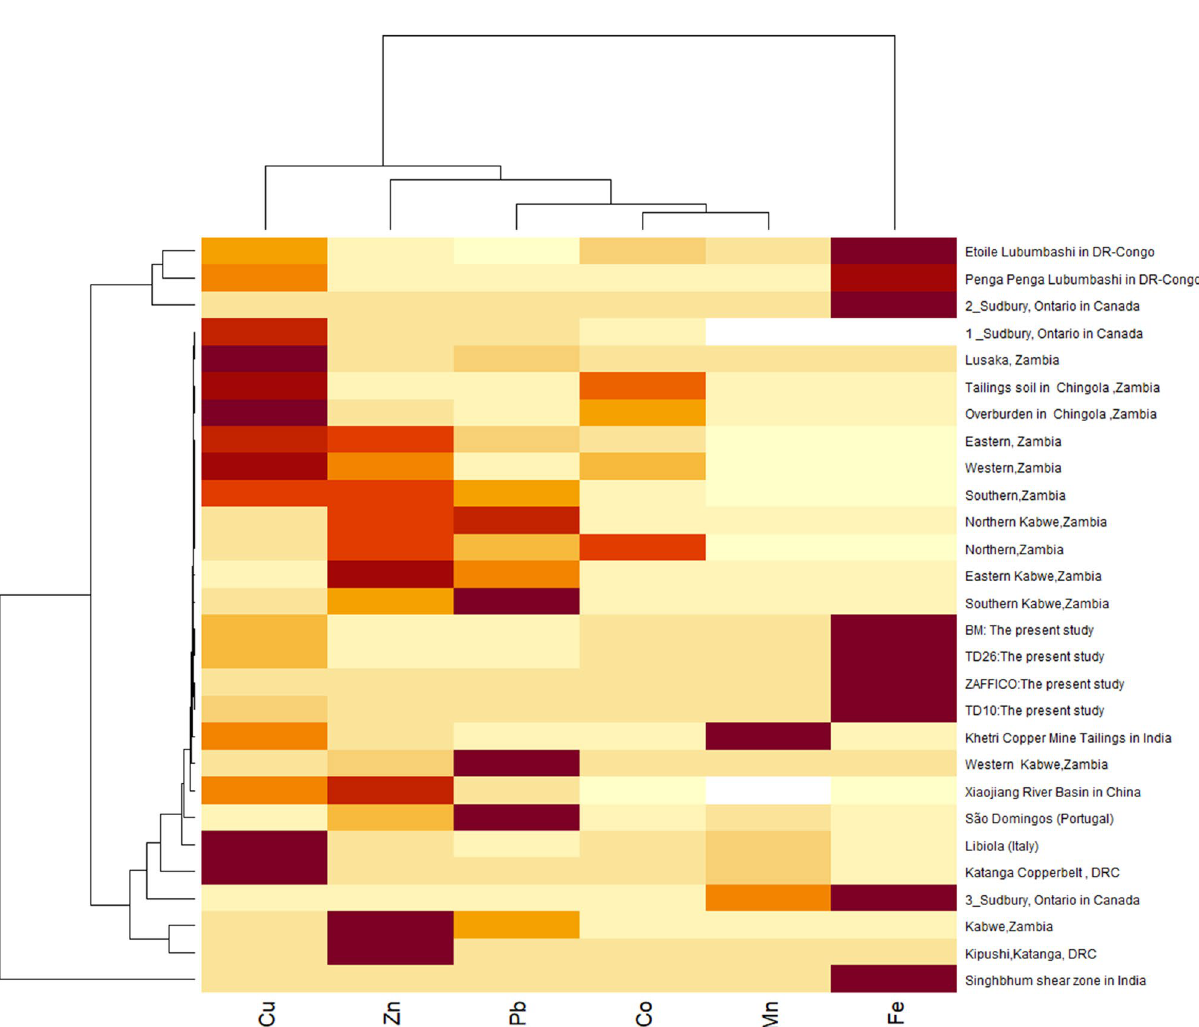
Figure 7. Heatmap analysis of heavy metals (Cu, Co, Fe, Mn, Pb, Zn) of mine soil in the present study with data from other studies in Zambia, DRC and